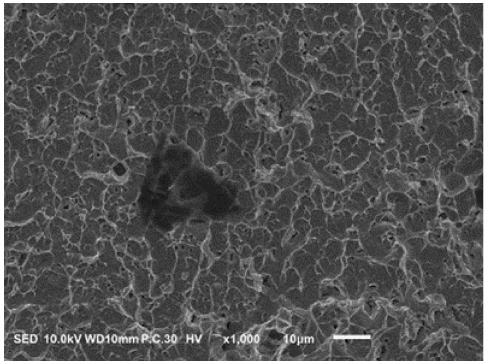
Figure 1. The SEM surface of PTU in static cycles. There is no striation on the entire